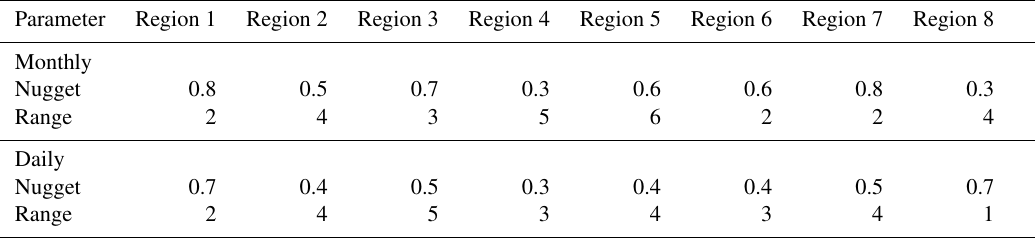
Table 4. Regional variogram parameters nugget (relative to sill) and range ( ◦ rot. grid) based on experiments with wind speed data V avg of 4 example months (January 2001, July 2001, January 2010 and July 2010). Listed are the regional averages for monthly and daily